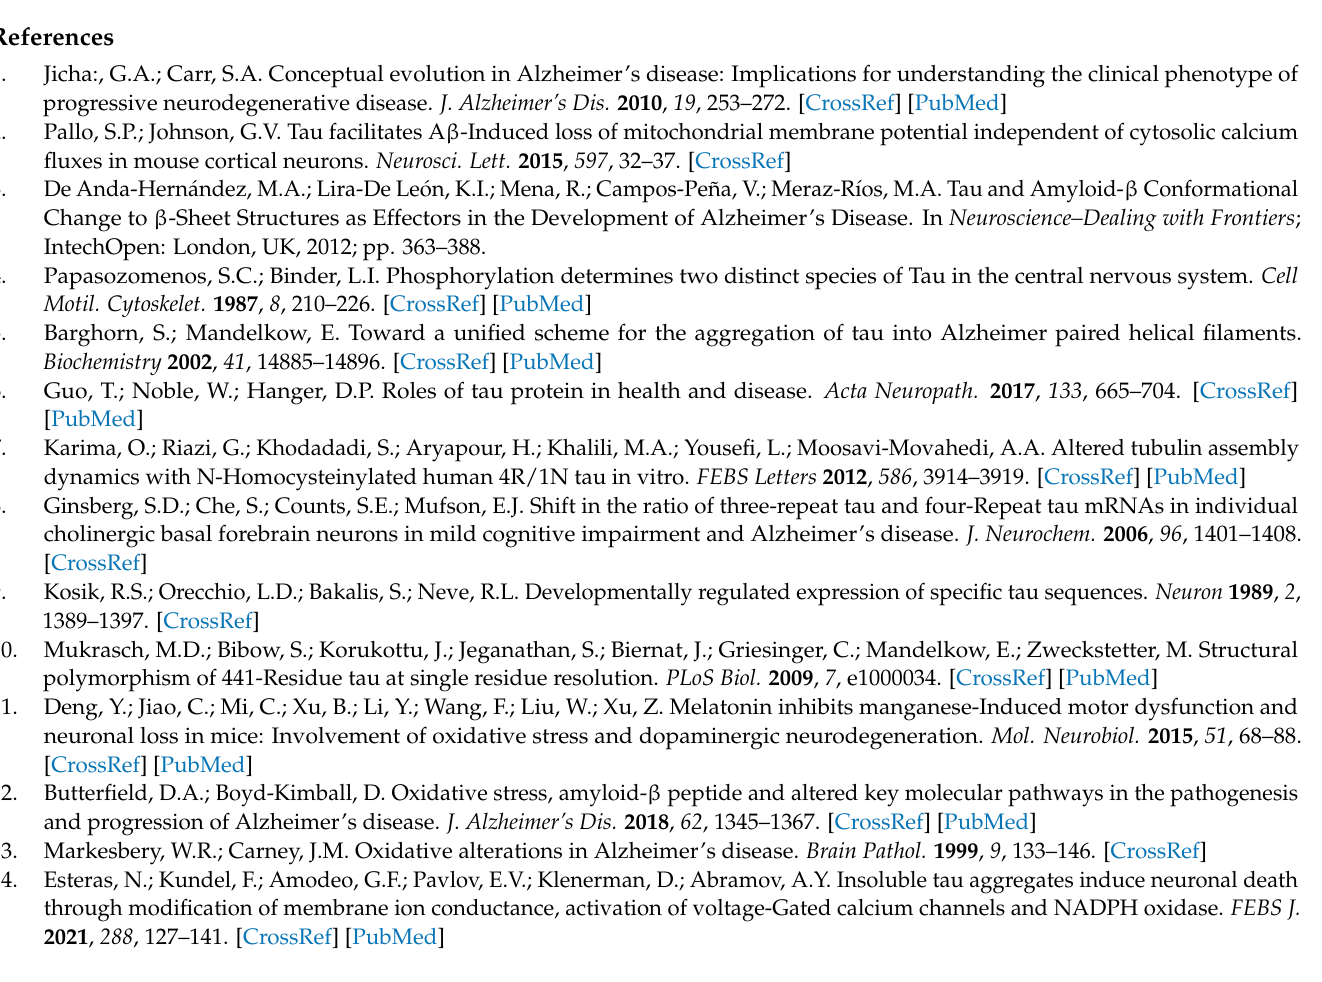
Supplementary Materials: The following are available online at https://www.mdpi.com/article/10.3 Table S2: Hydrogen-bond interactions of Cluster A. All distances are shown in interactions of cluster B. All distances are shown in All distances are shown in (cid:16) (cid:17) Å . Table S6: Hydrogen-bond interactions of Cluster C. All distances are shown in interaction of Cluster C. All distances are shown in